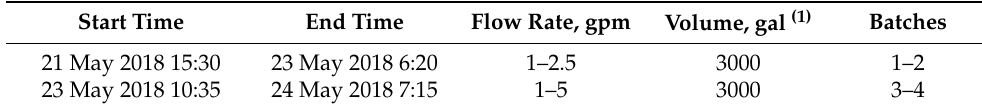
Table A10. Times and flow rates of sodium acetate injection. Start Time